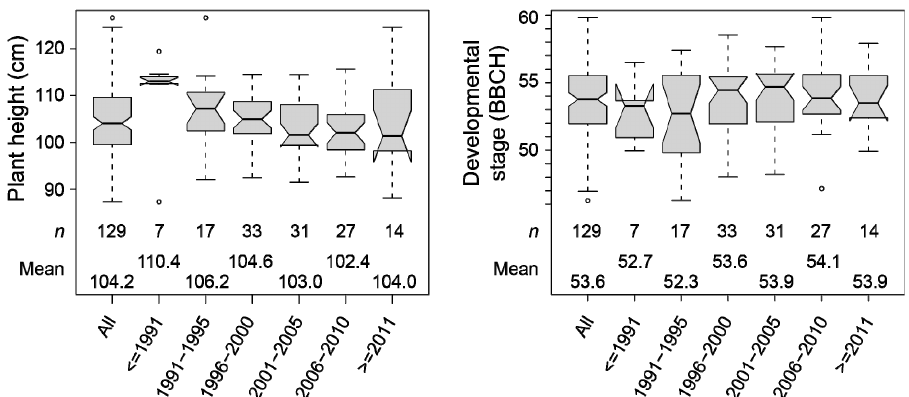
Figure 1. Development of plant height and developmental stage in the 129 registered cultivars dependent on their year of release.